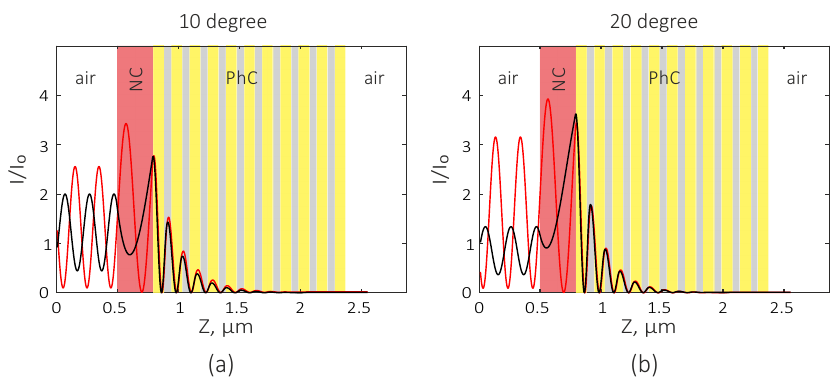
Figure 7. Angular and frequency dependences of the reflectance spectra (red line) of the PhC/nanocomposite structure for the TE and TM modes. The filling factor is f = 0.11 and d eff = 300 nm. Purple and green fillings denote the (cid:60) ε eff < 0 and photonic band gap, respectively.